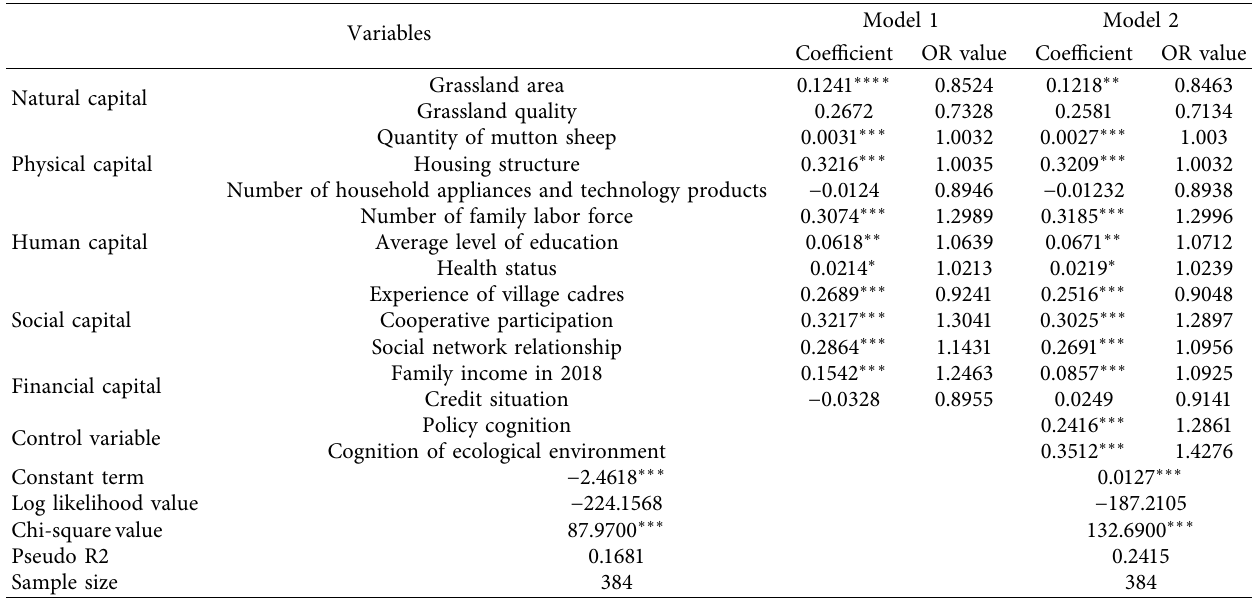
Table 4: Regression results of livelihood capital and environmental cognition measurement indexes on Herdsmen’s production